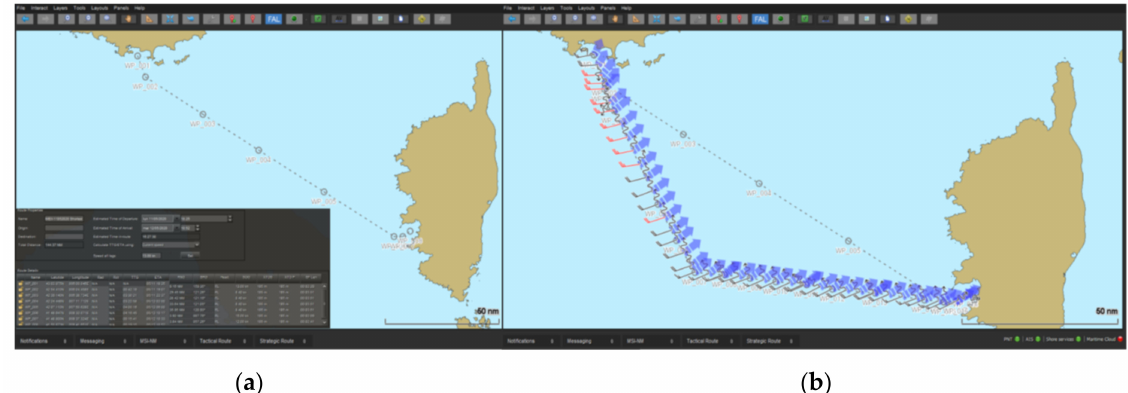
Figure 1. ECDIS-like routes visualization and editing in the prototype interface. Left panel ( a ): the shortest route from Toulon (France) to Ajaccio (Corse Island). Right panel ( b ): a little more zoom on the area and addition of a variated route with voyage timing-related metocean data shown with standard ECDIS-like